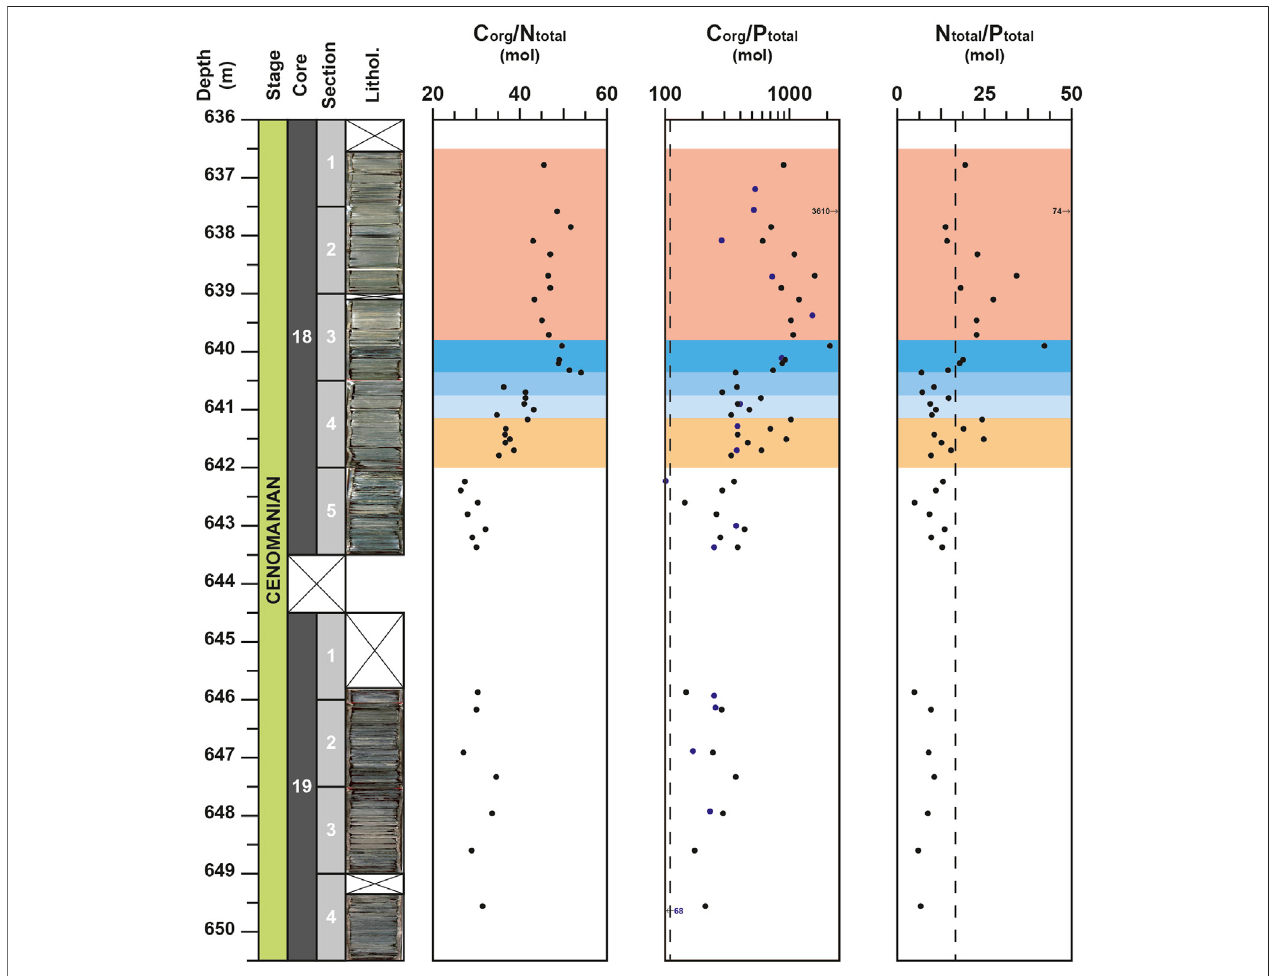
FIGURE 3 | Depth-pro fi les for C org/ N total , C org /P total and N total /P total molar ratios for the DSDP site 367. Data from the studies of Kuypers et al., 2002 and Kuypers et al., 2004) are represented with blue circles. Vertical dotted lines represent the Red fi eld ratio value (106 for C org/ P total and 16 for N total /P total ).